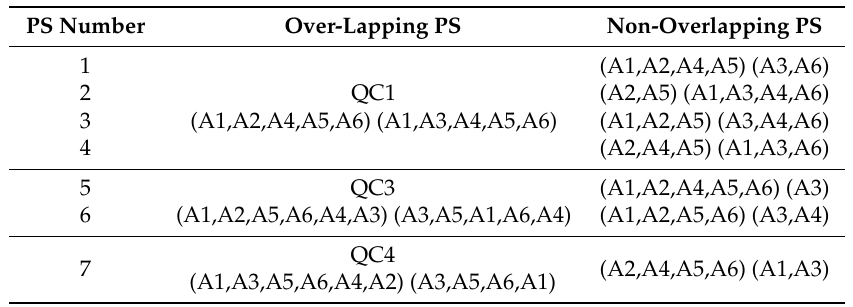
Table 10. Refinement process results.